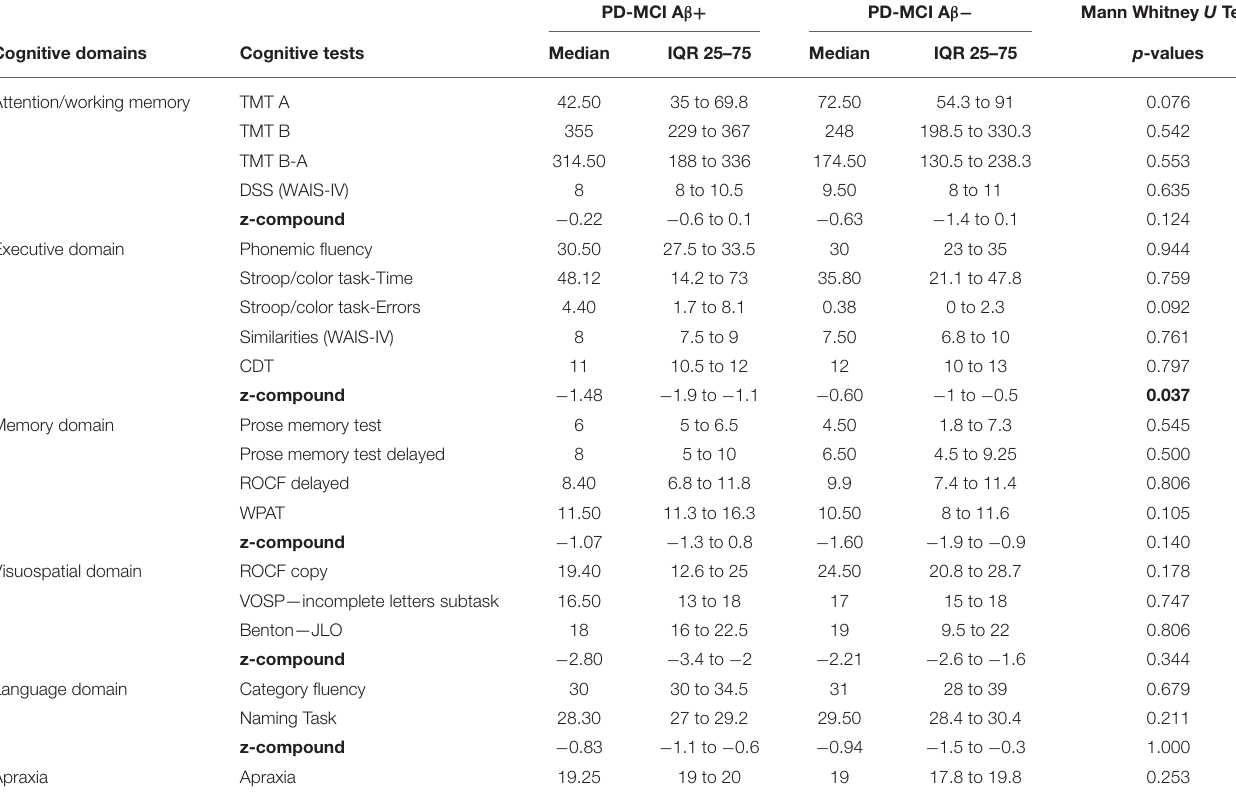
TABLE 2 | Comparison of the neuropsychological scores between PD-MCI subgroups (A β + vs. A β